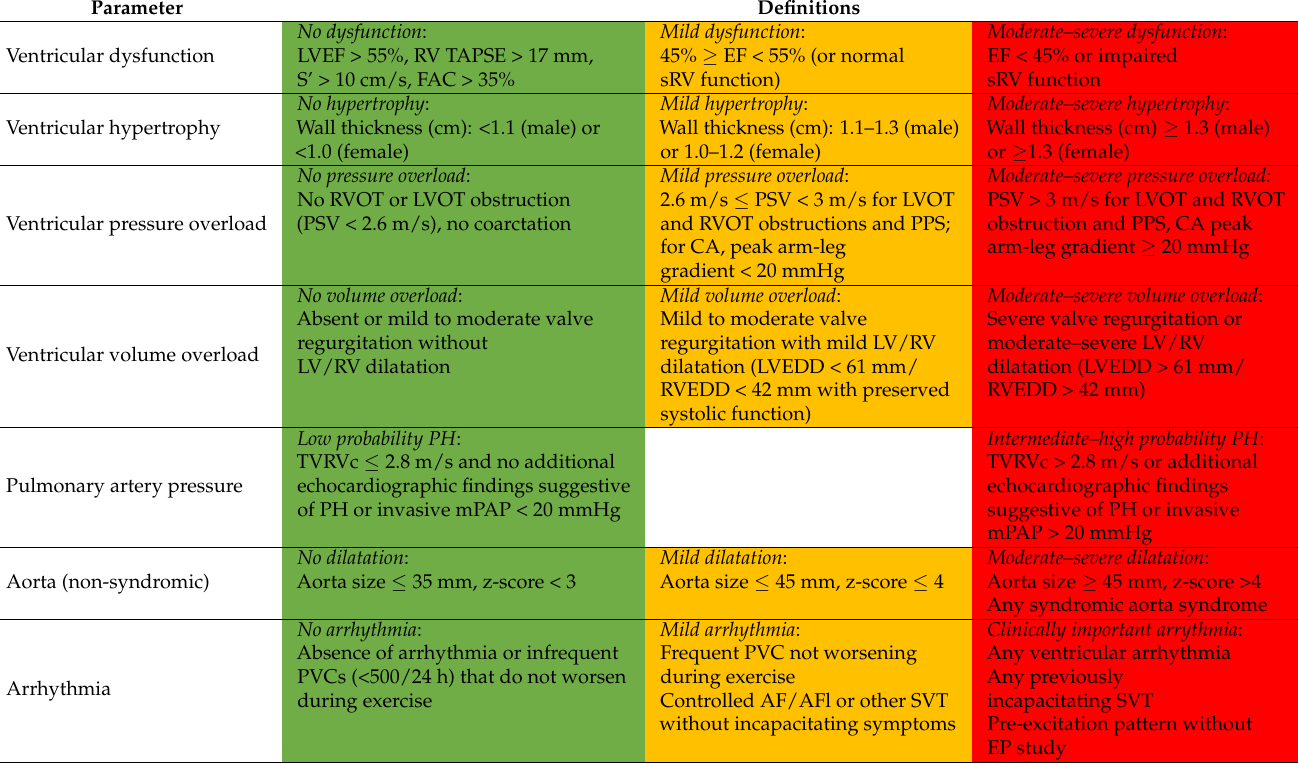
Table 1. Assessment of nine parameters at rest